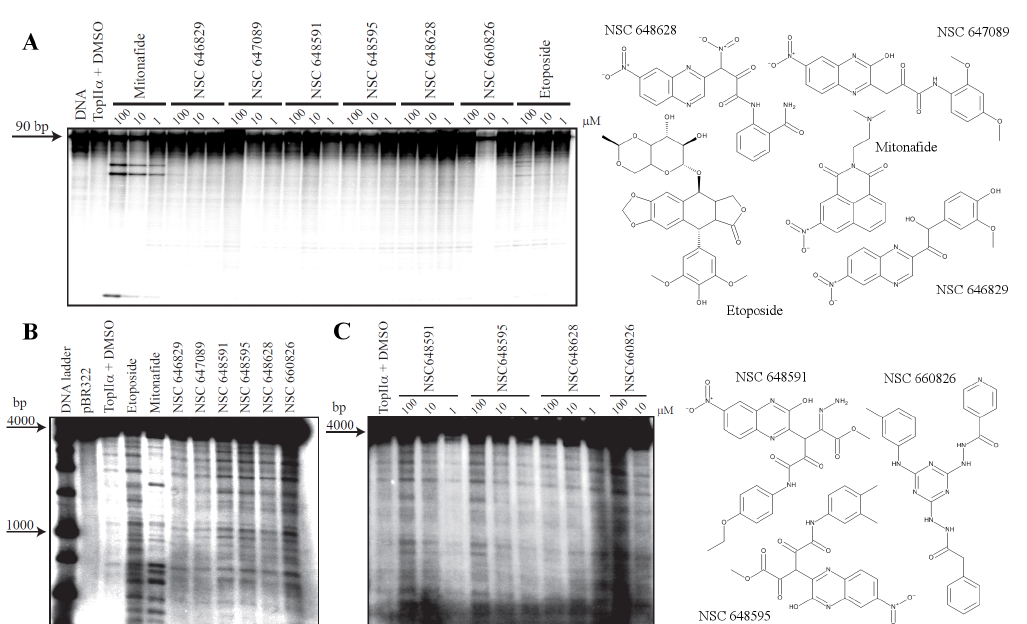
Fig. 4. Topoisomerase 2 a -mediated DNA cleavage by mitonafide, etoposide and in silico selected compounds. Structures of tested compounds and controls are shown on the right. A) Compounds were tested on a portion of SV40 sequence at three different concentrations (100, 10 and 1 m M). The first lane represents the DNA without enzyme and the second lane the DNA with enzyme in presence of DMSO (drug solvent). B) Same as in (A) but compounds were tested on pBR322 plasmid DNA at 100 m M concentration. C) The four active inhibitors of Top2 a identified in (B) were additionally tested at 100, 10 and 1 m M concentration on pBR322